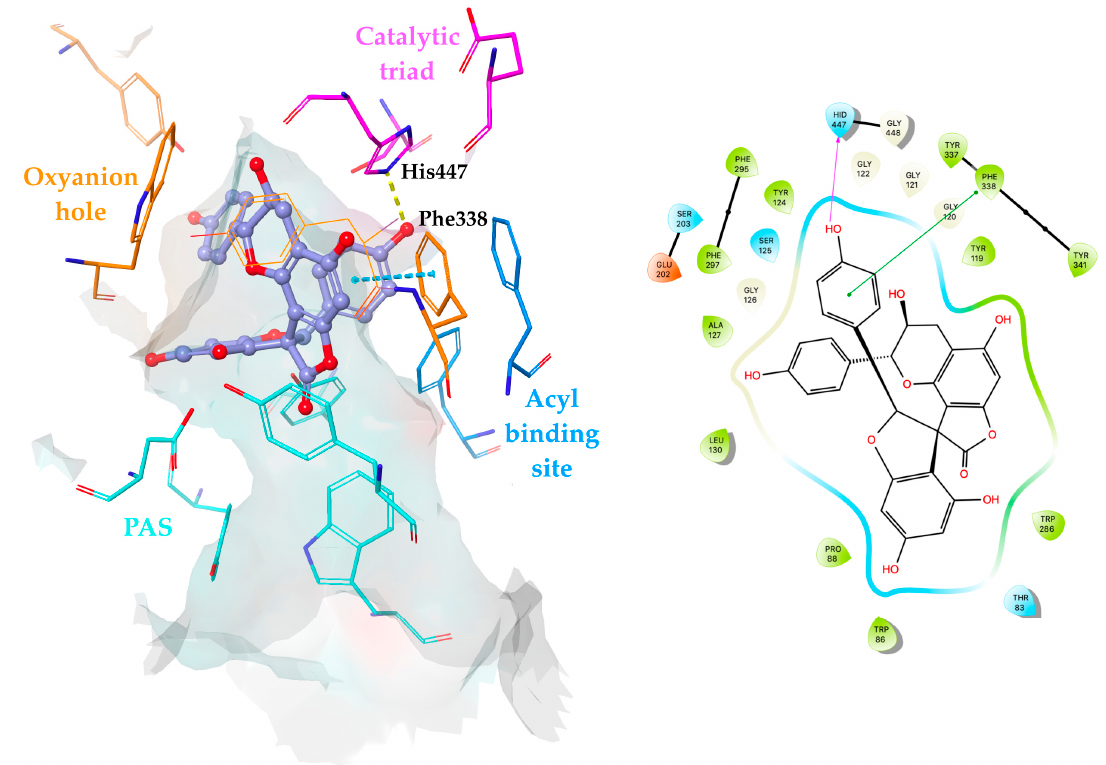
Figure 10. Proposed binding mode and 2D interaction map for 29 (presented as a purple ball and stick model) in the hAChE active site (PDB: 4EY7). Hydrogen bonds and π – π stacking contacts are represented by yellow and cyan dashed lines, respectively.